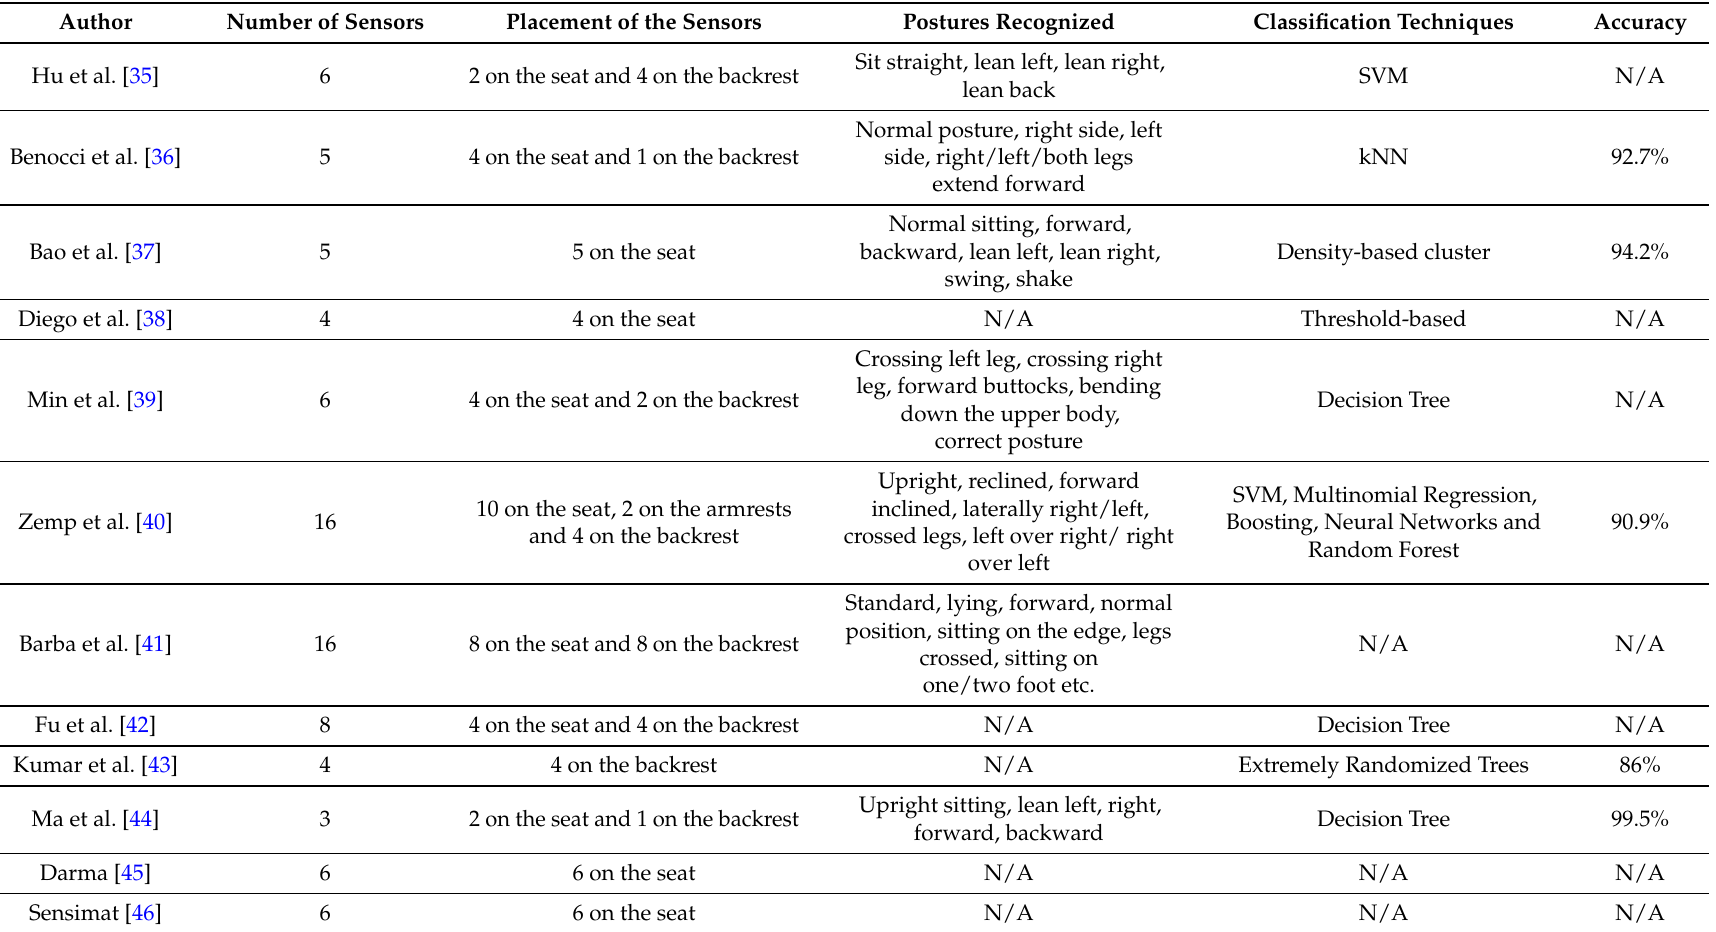
Table 2. Smart cushions based on fewer individual pressure